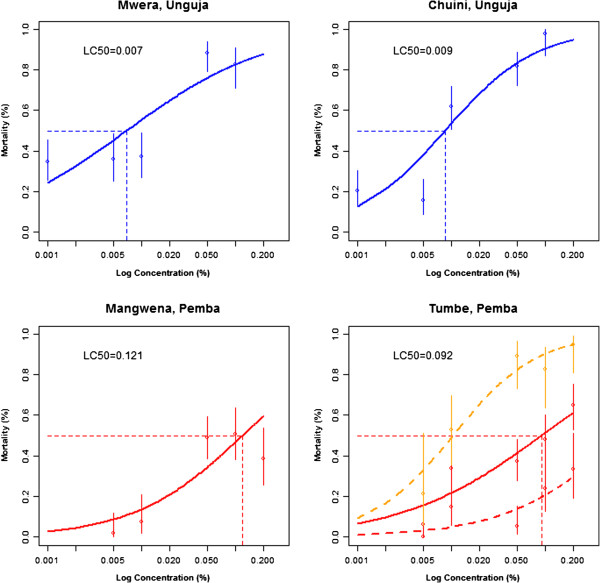
Dose–response curves for An. arabiensis exposed to lambda-cyhalothrin on Zanzibar. An. gambiae were exposed to a range of concentrations of lambda-cyhalothrin in WHO susceptibility tests. The lethal concentration for 50% mortality (LC50) was calculated by fitting a generalised linear model (GLM) using a binomial logit-link function. The LC50 is shown above each plot. For Tumbe, two additional curves are shown specific for An. arabiensis (red dashed) and An. merus (orange dashed).